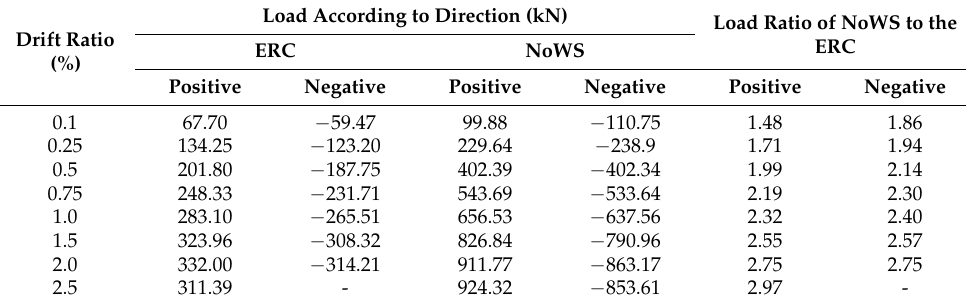
Table 4. Summary of experimental results.